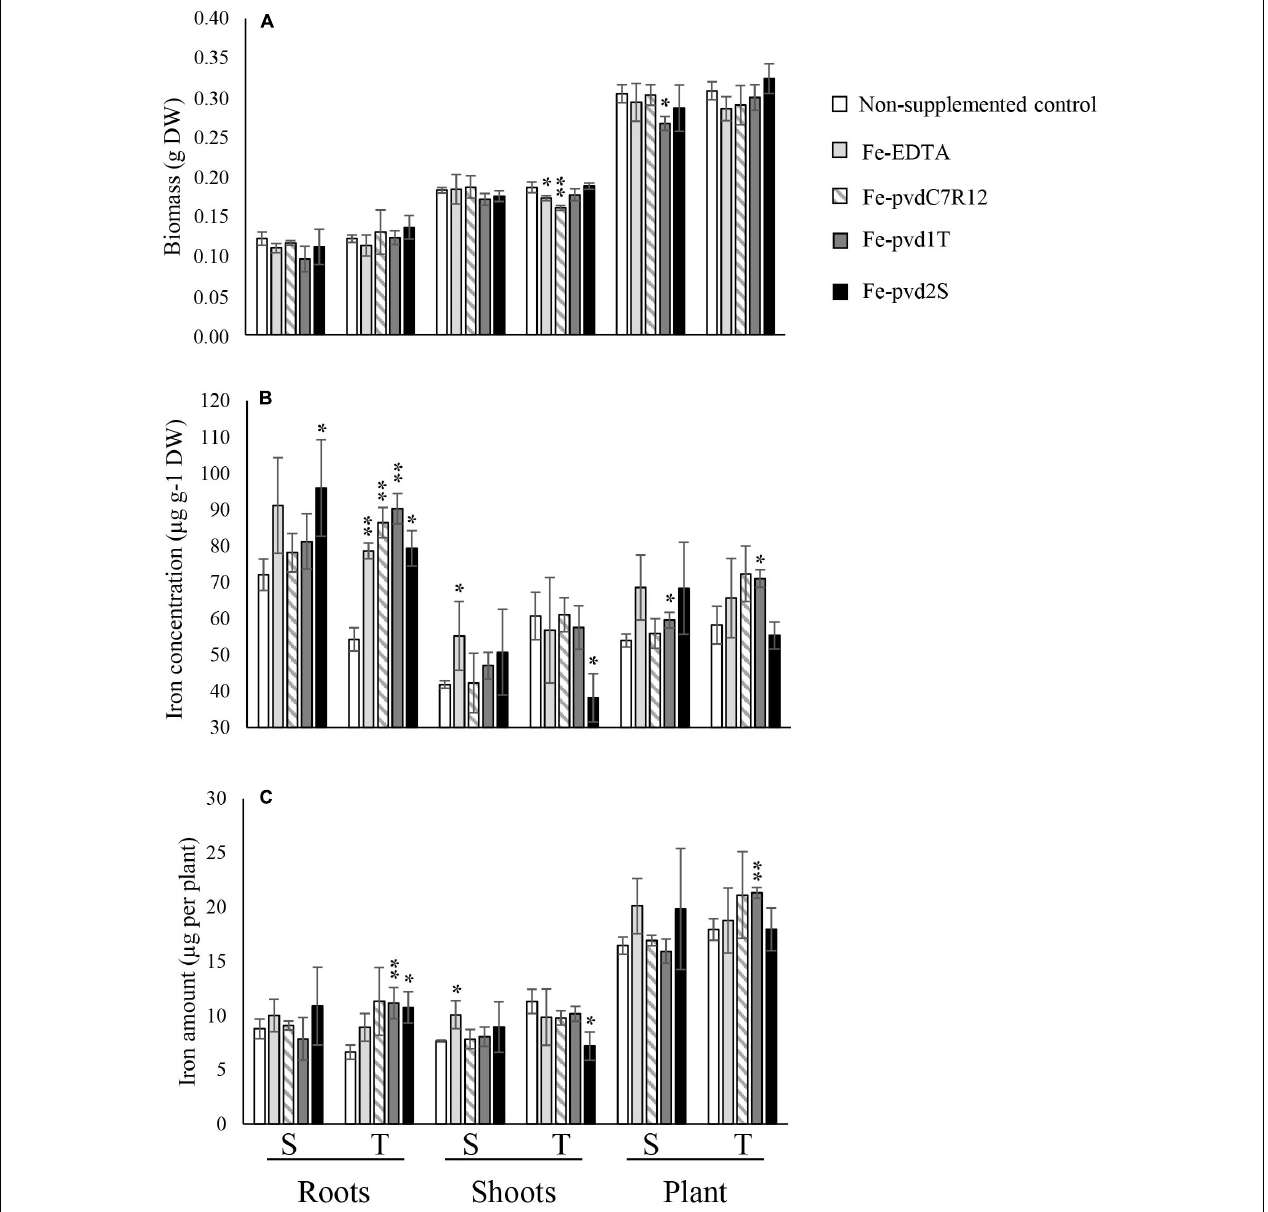
FIGURE 2 | Effect of iron supplementation in the form of three ferripyoverdines, Fe-pvdC7R12, Fe-pvd1T, and Fe-pvd2S on (A) biomass, (B) iron concentration, and (C) iron content in two pea cultivars, tolerant (T) and susceptible (S) to iron chlorosis ( n = 3). Error bars represent the s.d. of the mean. P value was calculated using one-way ANOVA between the supplementation treatment and the non-supplemented control within a same plant compartment and in a same pea cultivar. * p < 0.05; ** p < 0.01.